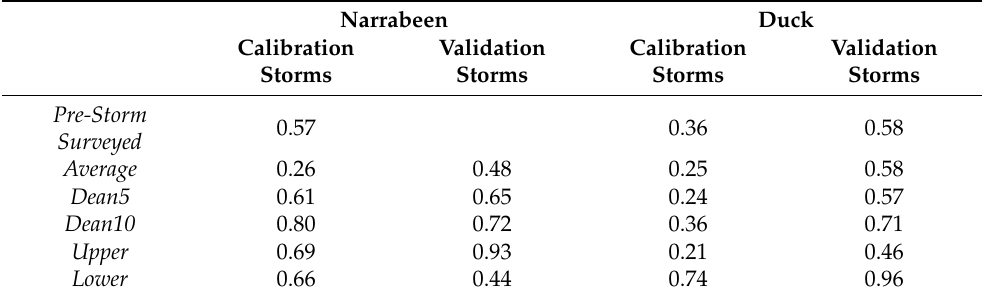
Table 3. Average RMSE for the six assumed initial surf zone and nearshore bathymetries used for storm modelling. The calibration and validation storms (refer to Table 1) are shown